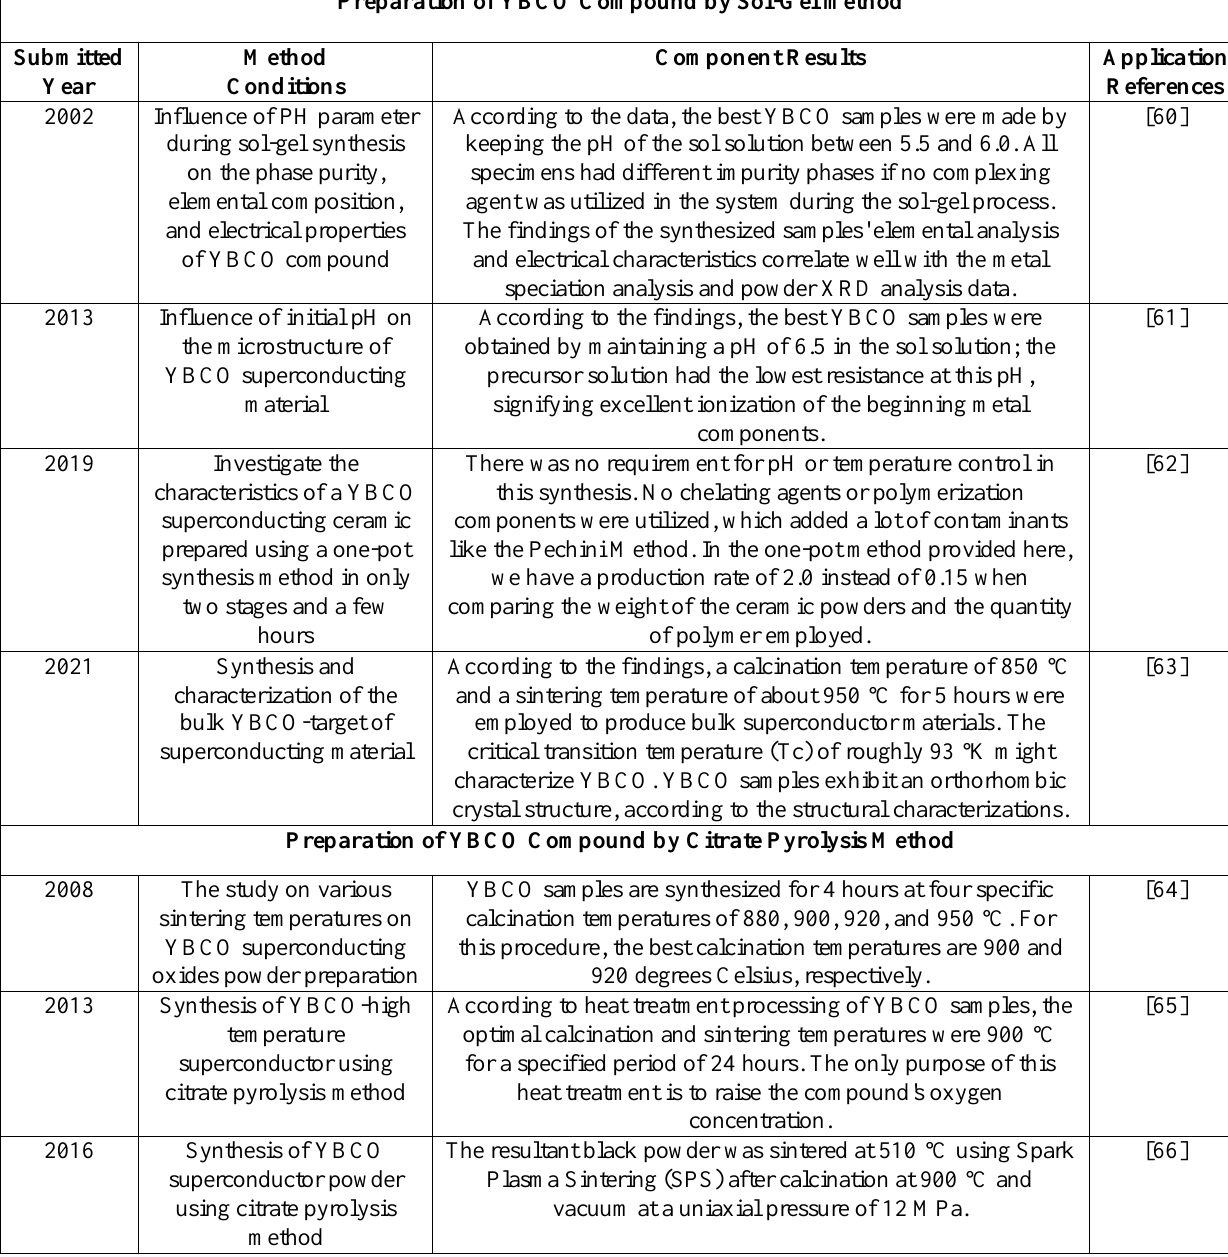
Table 1: Presents some recent studies on the BSCCO compound and its preparation as powder and thin film. Preparation of YBCO Compound by Sol-Gel